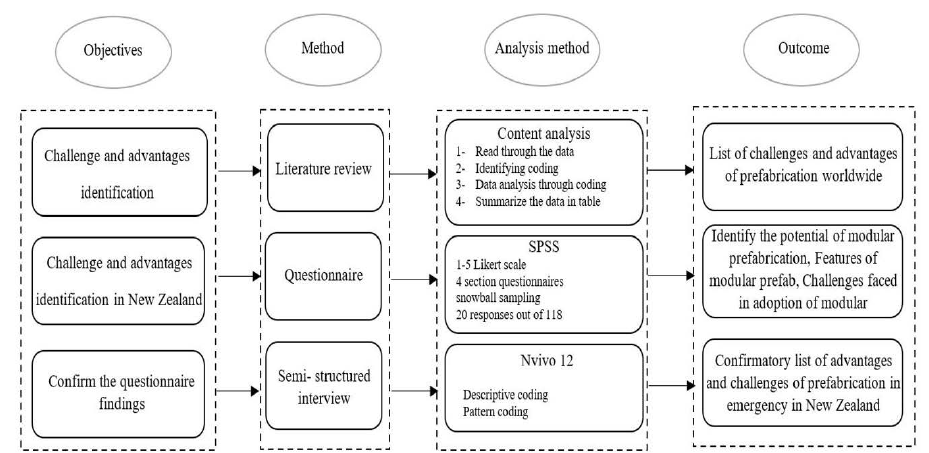
Figure 4. Research Design and Implementation